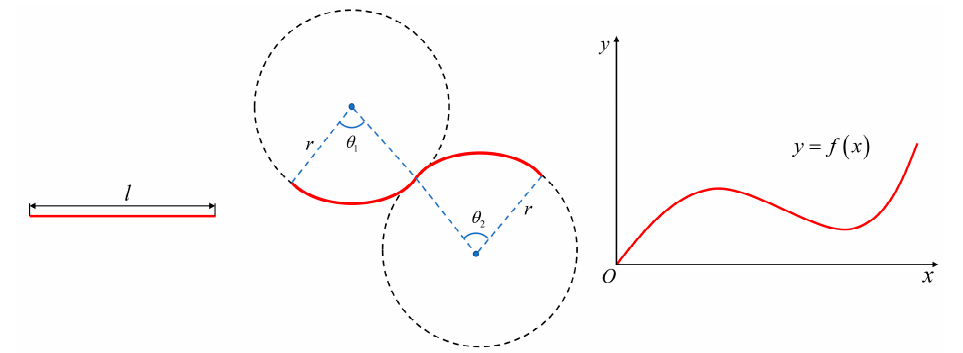
Figure 2. Wall modeling.